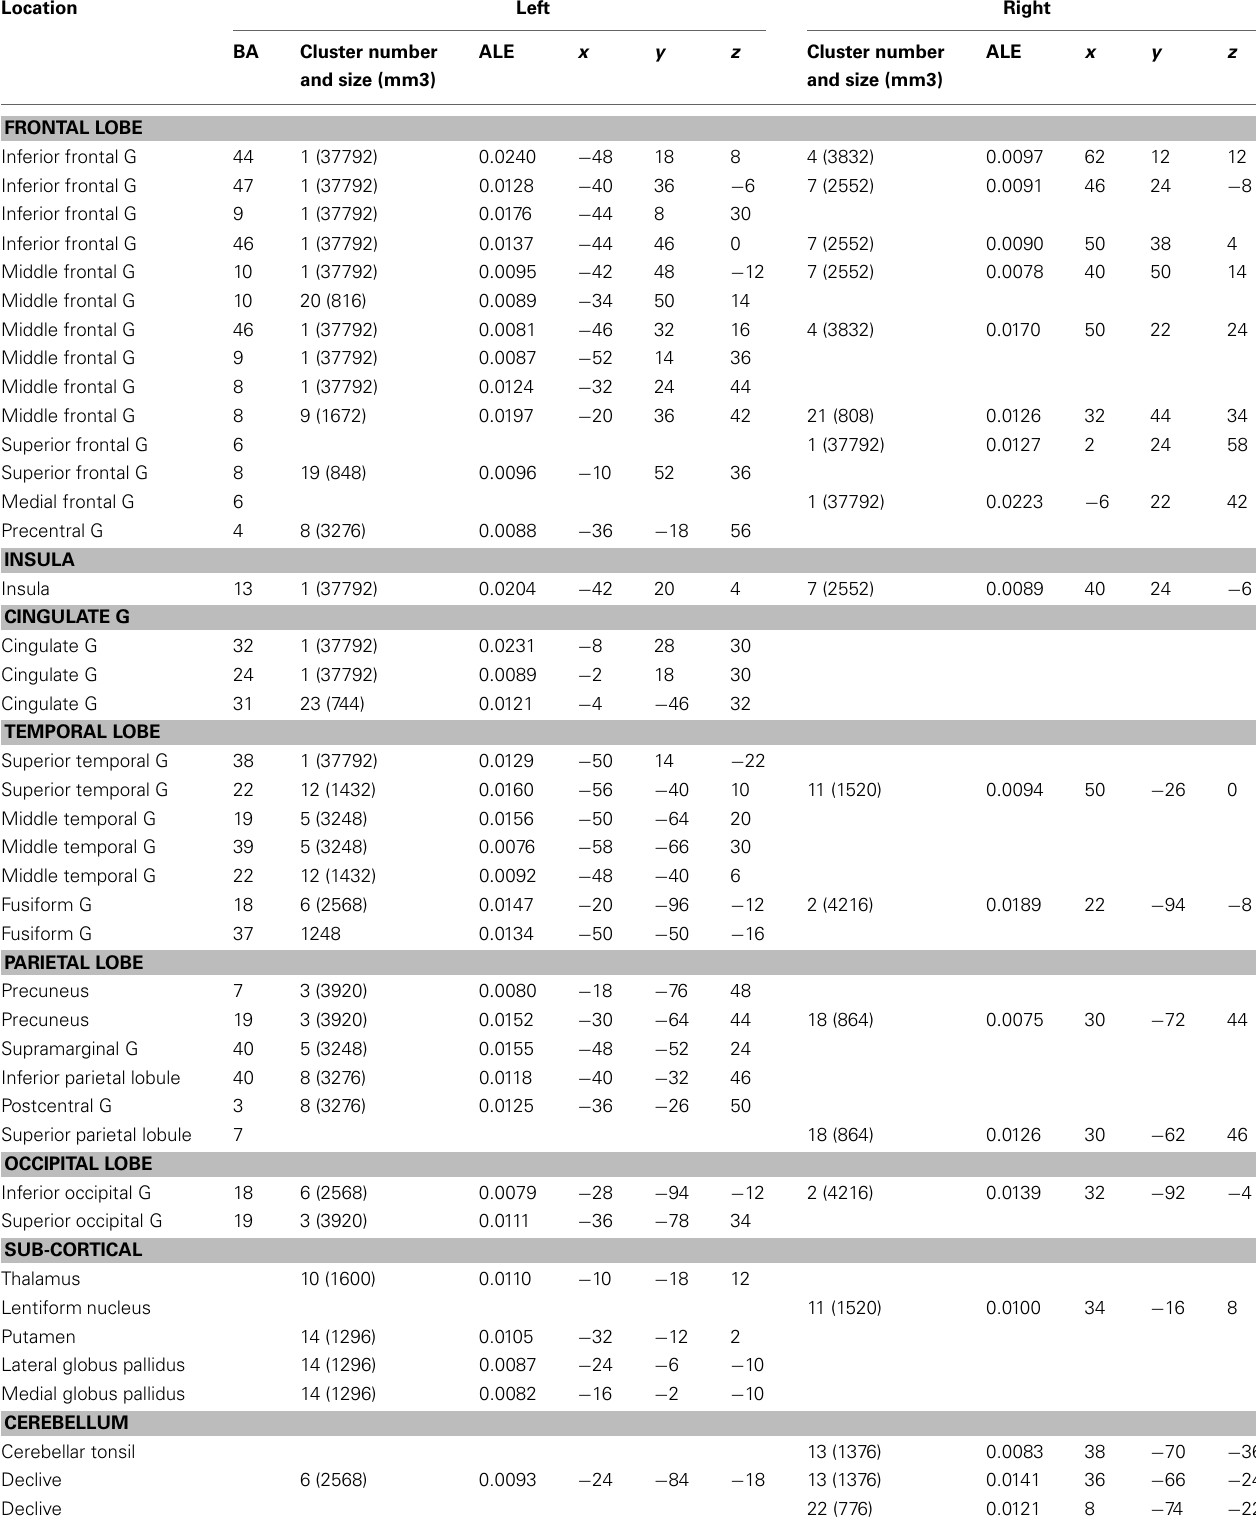
Table 6 | Locations of clusters with significant ALE values for verbal